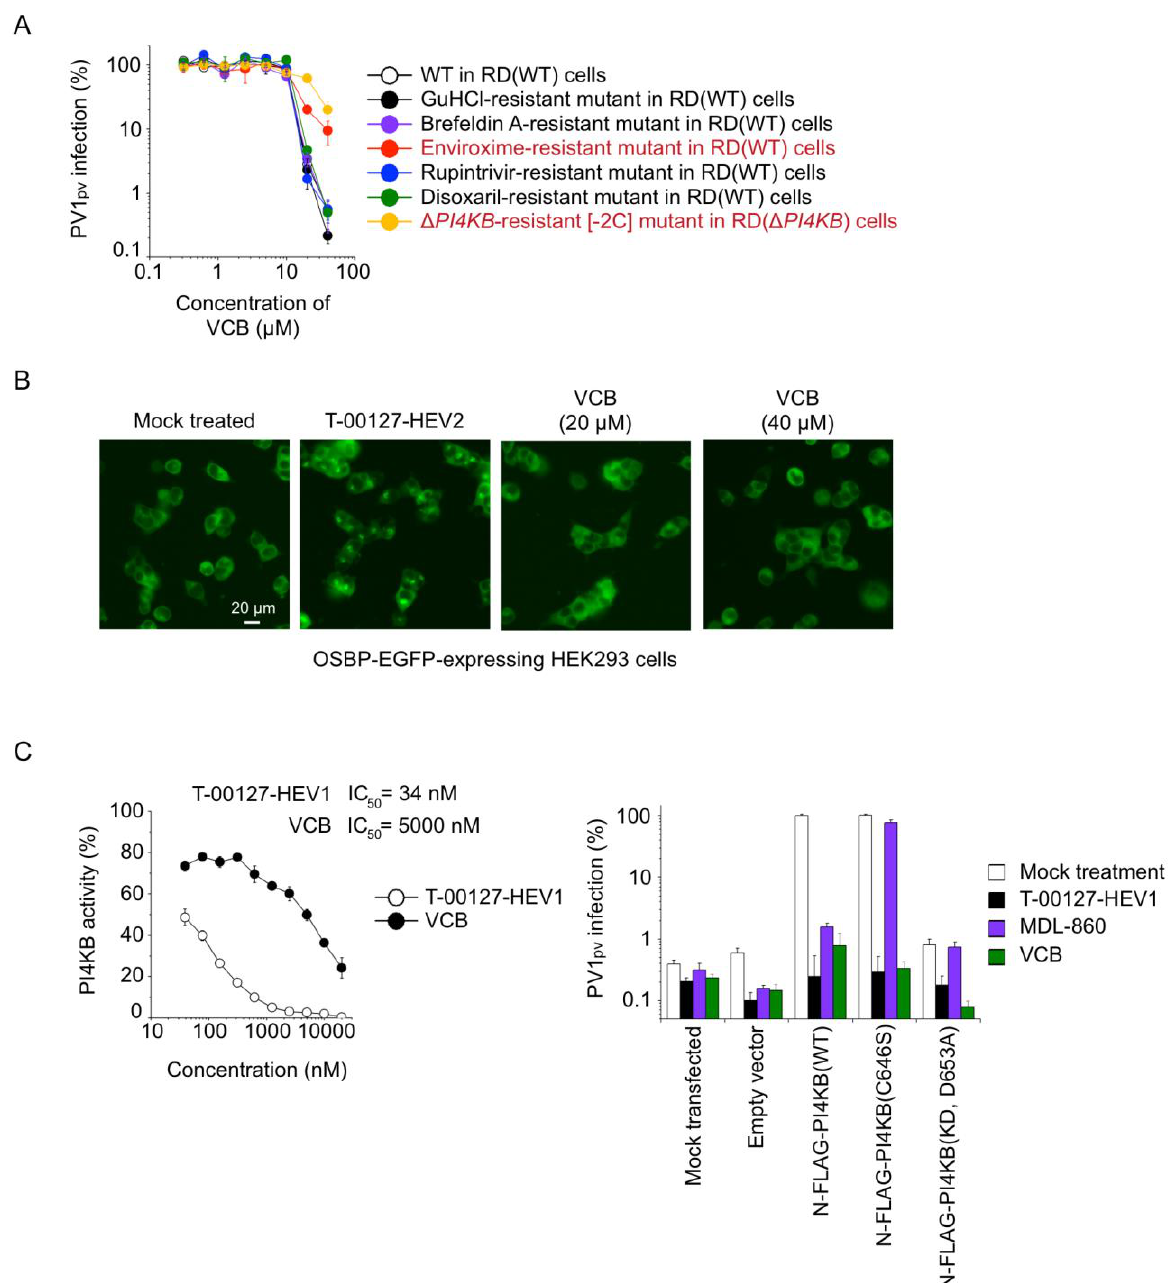
Figure 4. VCB is a novel PI4KB inhibitor. ( A ) Inhibitory effect of VCB on the infection of a panel of drug-resistant PV1 pv mutants. PV1 pv infection at 7 h p.i. in RD(WT) cells in the presence or absence of VCB is shown, except for the infection of the Δ PI4KB -resistant [-2C] mutant, which was analyzed at 17 h p.i. in RD(Δ PI4KB ) cells. PV1 pv infection in the absence of VCB is taken as 100%. ( B ) OSBP-EGFP-expressing HEK293 cells were incubated at 37 °C for 30 min in the presence of the compounds ( 10 μM T-00127-HEV2, 20 or 40 μM VCB, respectively ). Localization of OSBP-EGFP in the cells is shown. ( C ) (Left) Inhibitory effect of VCB on in vitro PI4KB activity. (Right) Trans -rescue of PV infection in RD(Δ PI4KB ) cells by indicated PI4KB variants in the presence of the compounds ( 20 μM T-00127-HEV1, 40 μM MDL-860, or 20 μM VCB, respectively ). PV1 pv infection in RD(Δ PI4KB ) cells transfected with pTK-N-FLAG-PI4KB(WT, C646S, or D653A variants) in the absence of the com- pound is taken as 100%. The data are representative of two independent experiments with three biological replicates.